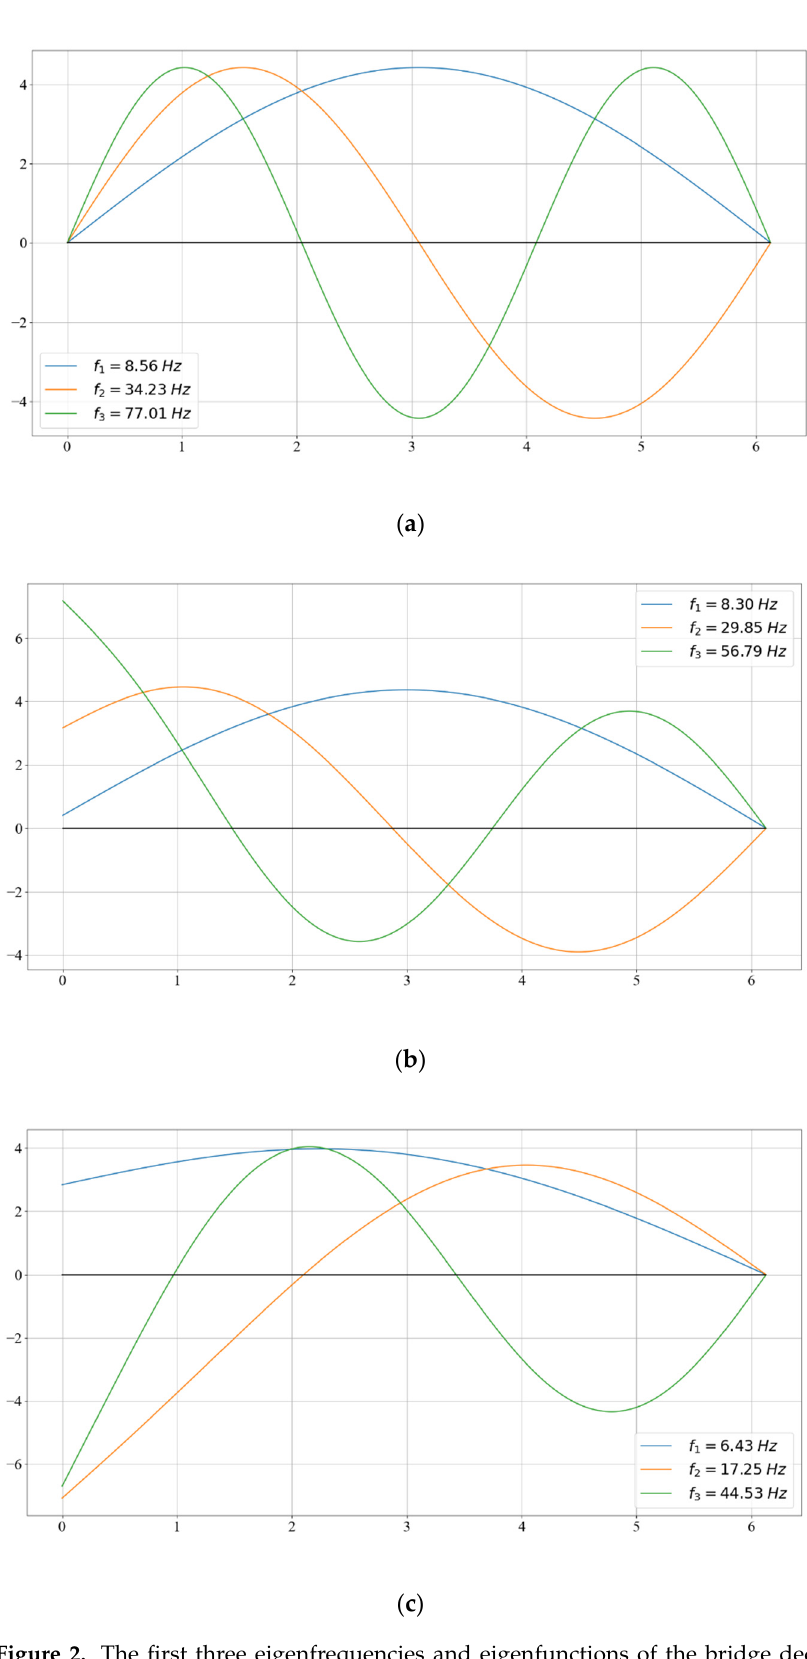
Figure 2. The first three eigenfrequencies and eigenfunctions of the bridge deck for ( a ) simple supports at the two ends; ( b ) flexible left support with K 1 = 1000 kN/m and K 2 = ∞ ; ( c ) flexible left support with K 1 = 100 kN/m and K 2 = ∞ .